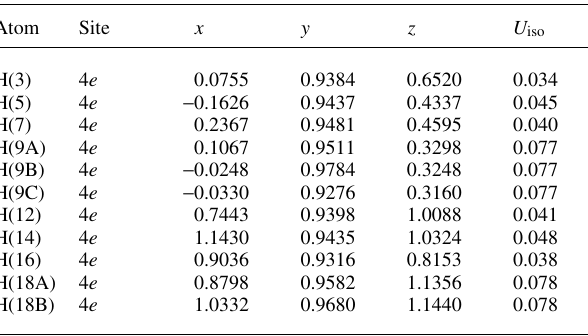
Table 2. Atomic coordinates and displacement parameters (in Å 2 ) .